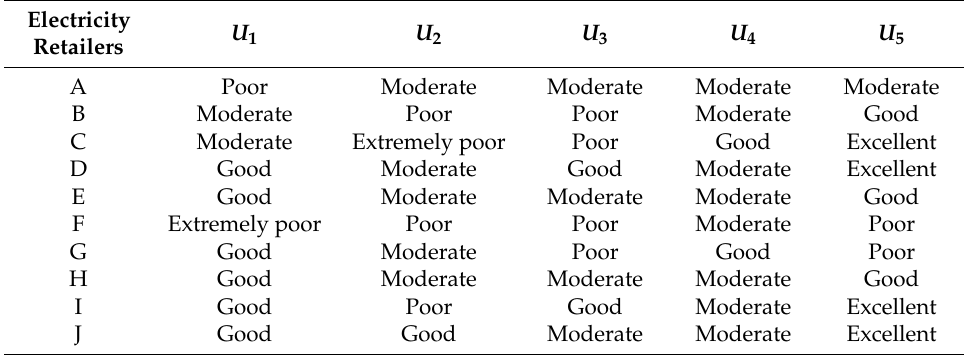
Level of energy saving and emission reduction effects for electricity retailers from a single dimension.